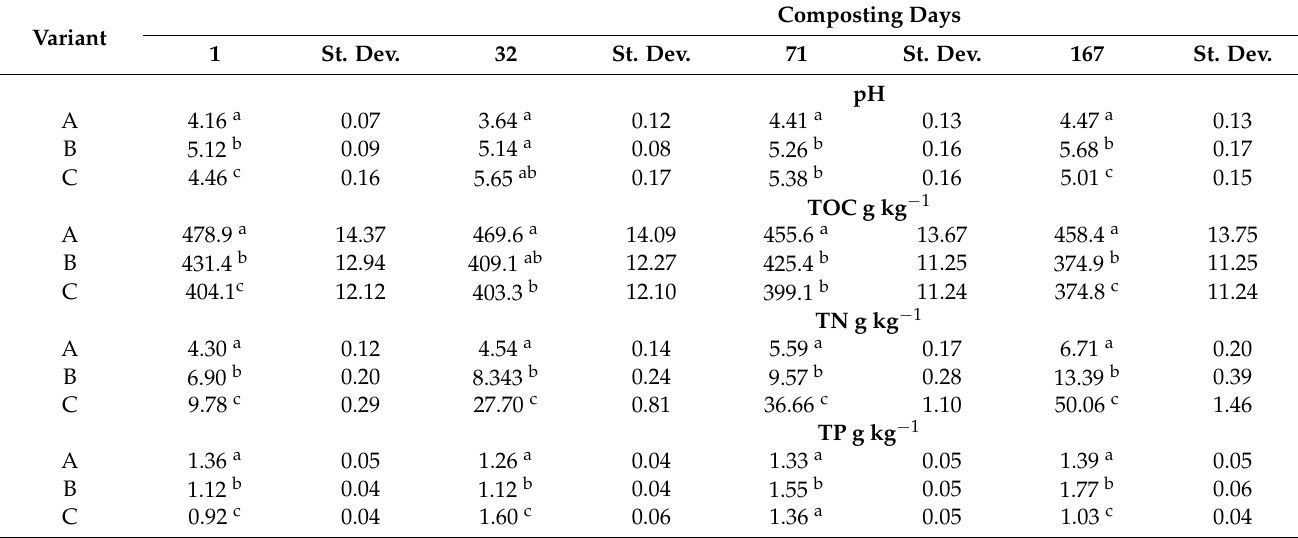
Figure 2. Changes in pH KCl during composting of willow chips. Table 1. Changes in basic chemical parameters of differently matured composts produced from